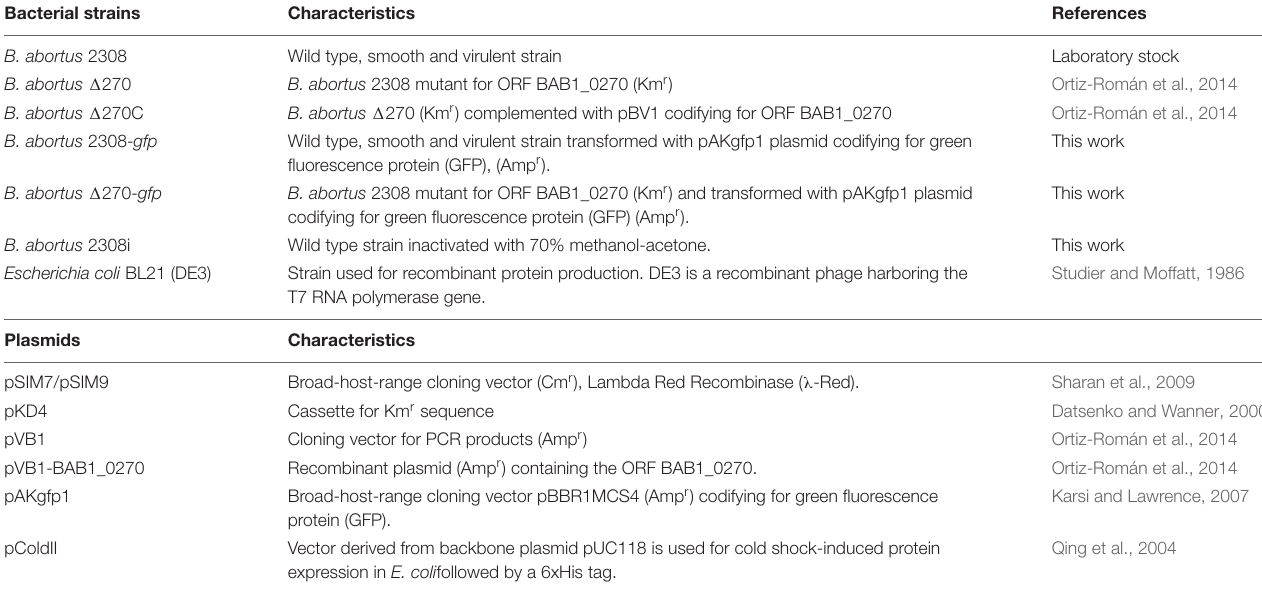
TABLE 1 | Bacterial strains, plasmids and primers used for mutant